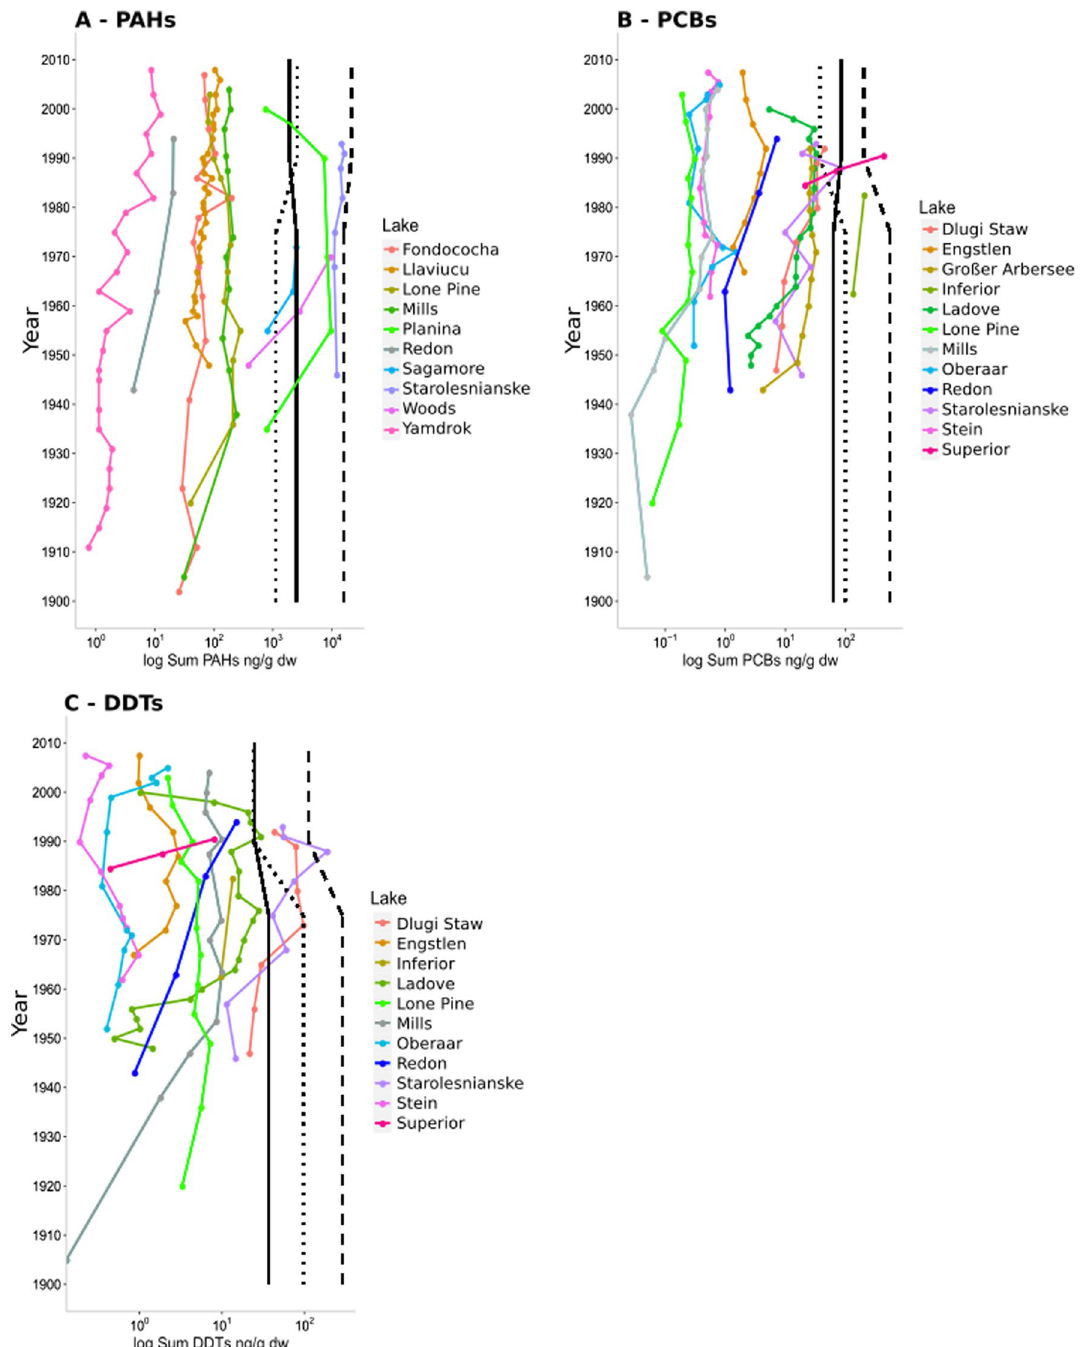
Fig. 3 Development of sediment concentrations in ng/g d.w. of different persistent organic micropollutants in various mountain lakes of the world over time. Development of A ∑ PAH concentrations, B ∑ PCB concentrations and C ∑ DDT concentrations. Vertical lines represent points of reference and show average concentrations of the 1970s and 90 s in lakes of the U.S. in urban (dashed line), light urban (dotted line) and remote − areas (solid line) (Additional file 1: Table